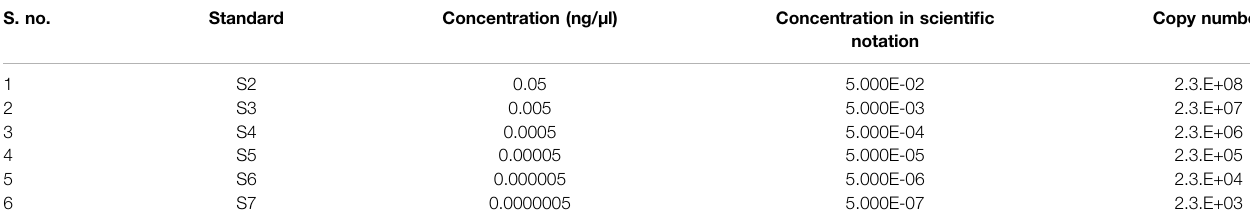
TABLE 4 | Serial dilution of